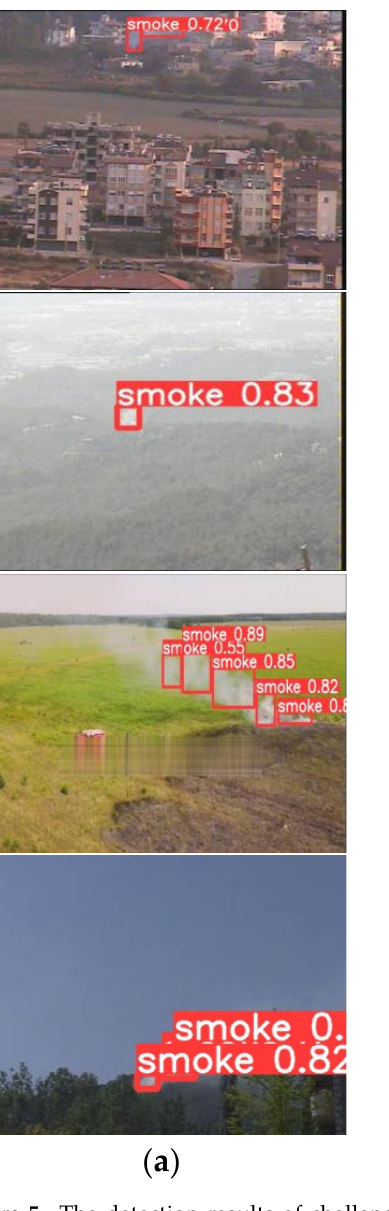
Table 3. Comparison of different smoke.